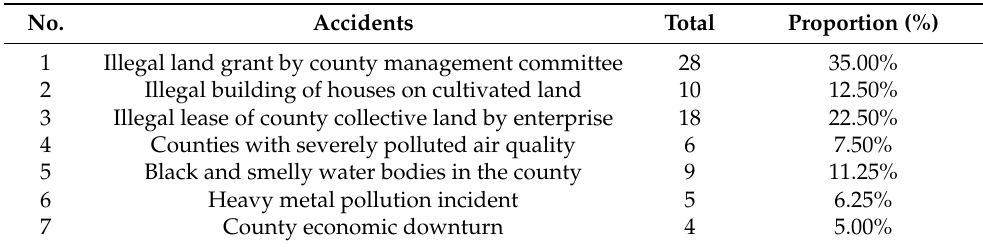
Table 1. Unsustainable county development